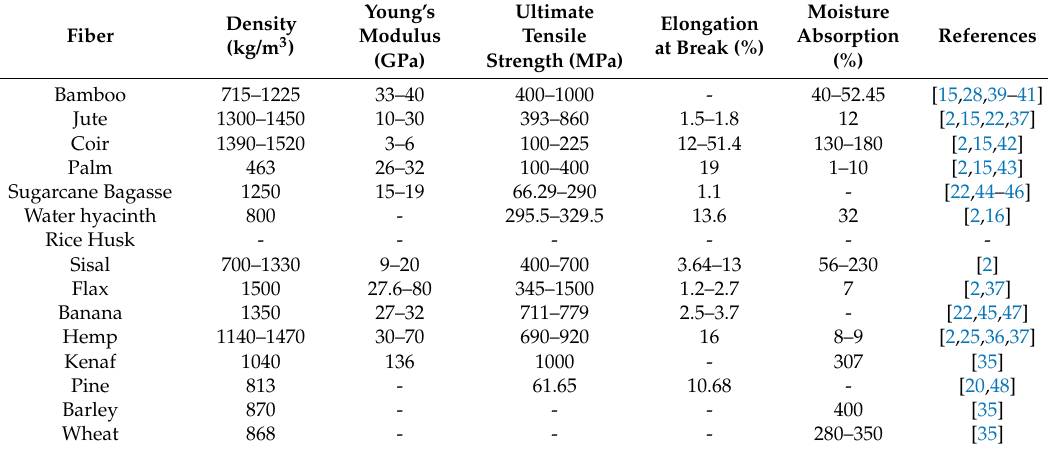
Table 3. Physical and Mechanical Properties of potential plant fibers in reinforcing the